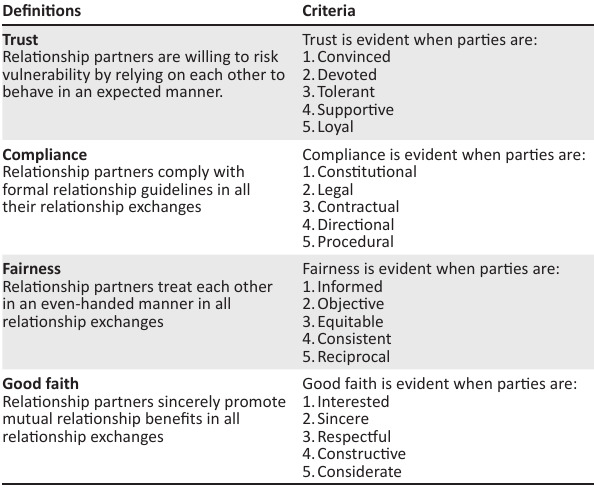
TABLE 1: Compliance, fairness, good faith and trust in employment relations. Definitions